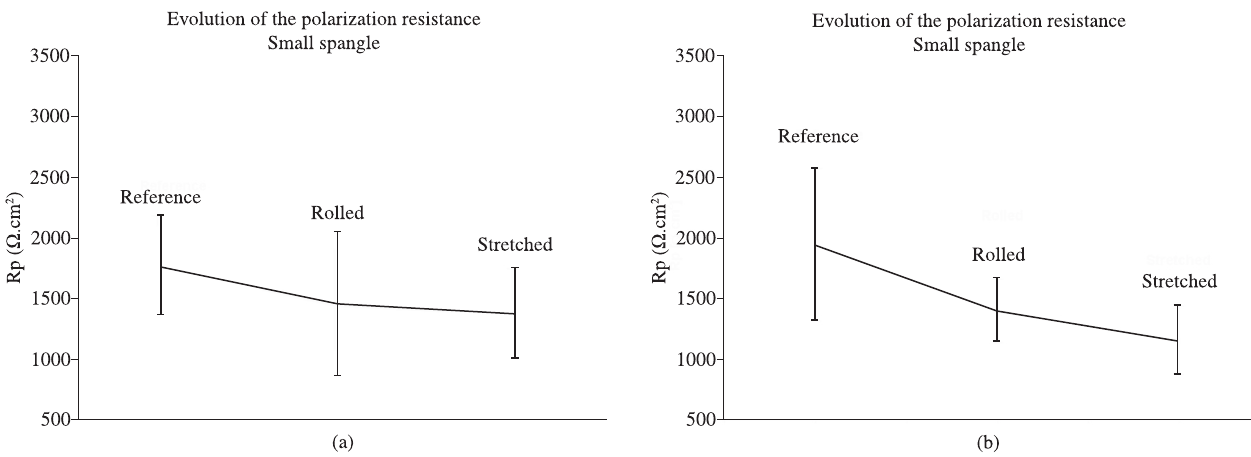
Figure 9. Polarization resistance dependence on the deformation type. a) Small spangle; b) Great